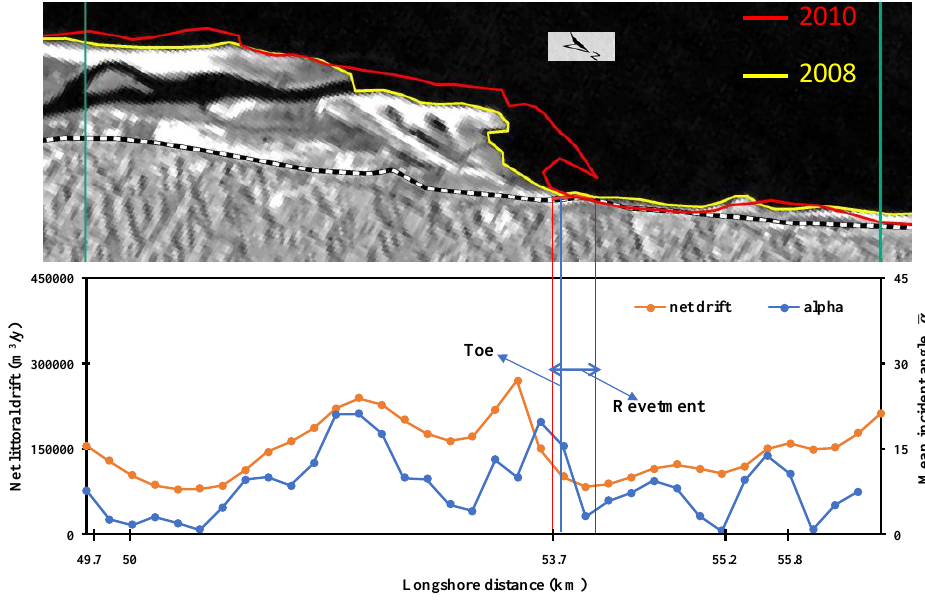
Figure 25. Distribution of the local wave incident angle and net littoral drift along the spit during 2008–2010.